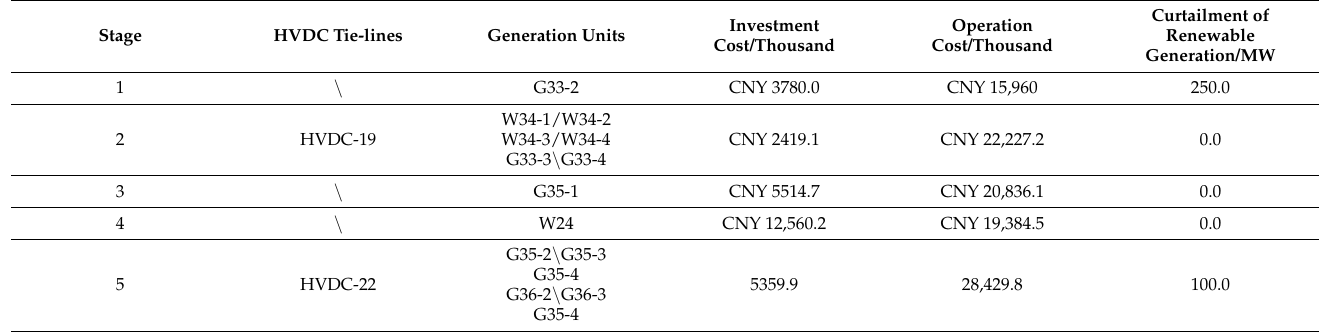
Table 1. The multi-period planning scheme based on the proposed model (Scheme